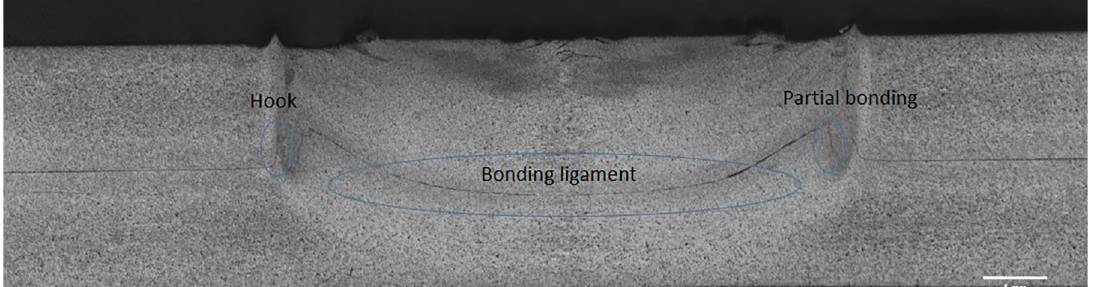
Figure 4. OM macrographs of a typical FSSW connection cross section showing the weld zones, geometric/metallurgical features.